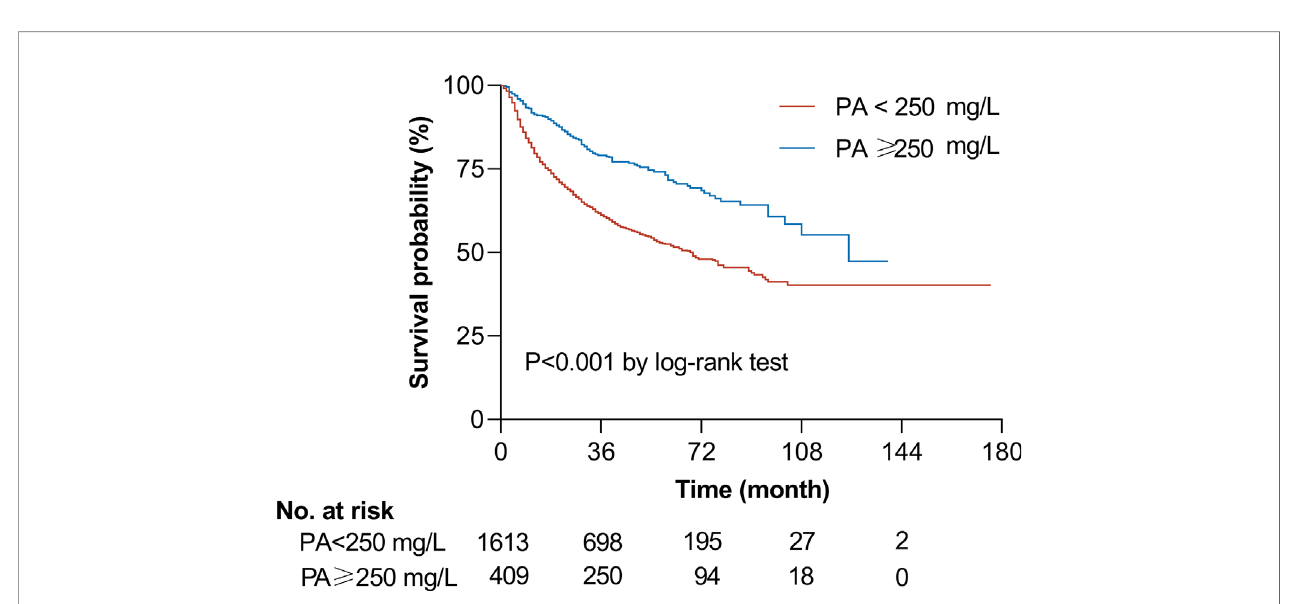
FIGURE 2 | | Unadjusted Kaplan-Meier curve of overall survival according to serum prealbumin (PA) level. The graph shows the survival probability according to serum prealbumin level in patients with a level above a threshold of 250 mg/L ( blue line , n = 409) or below the threshold ( red line , n = 1,613). The two groups differed signi fi cantly in survival, based on the log-rank test. The number of patients indicated in the table is the number of patients at risk at the indicated time.